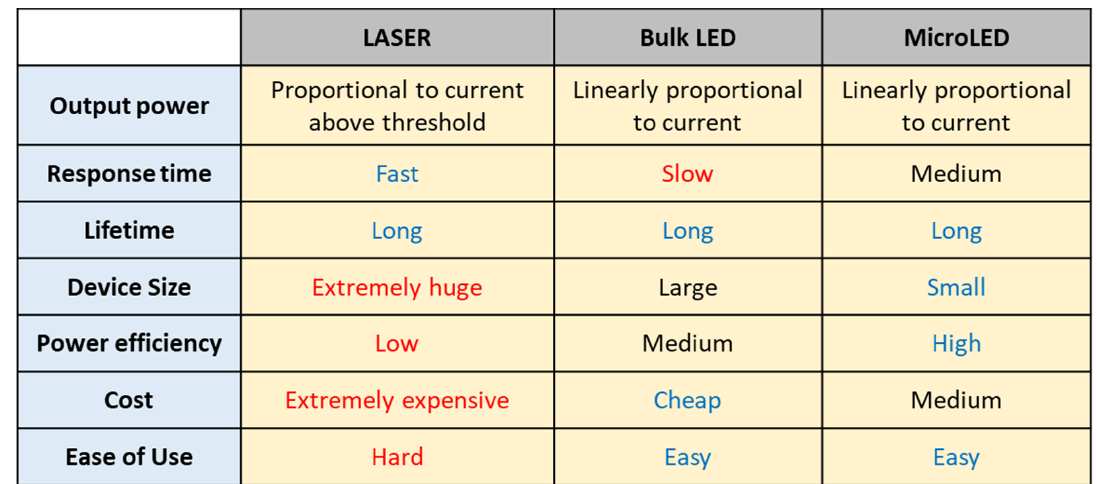
Figure 1. Comparison of LASER, bulk LED, and μ LED as a light source for biomedical applications (red: disadvantages, blue: advantages).